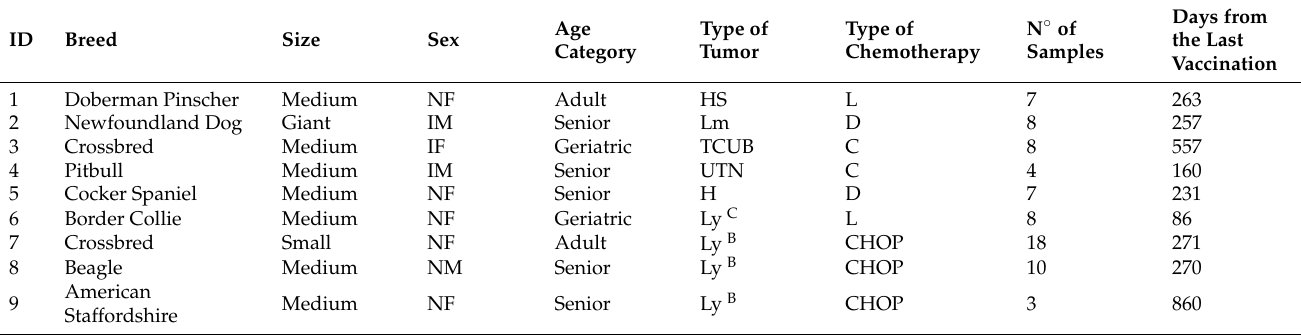
Table 2. Characteristics of the 21 patients included in this